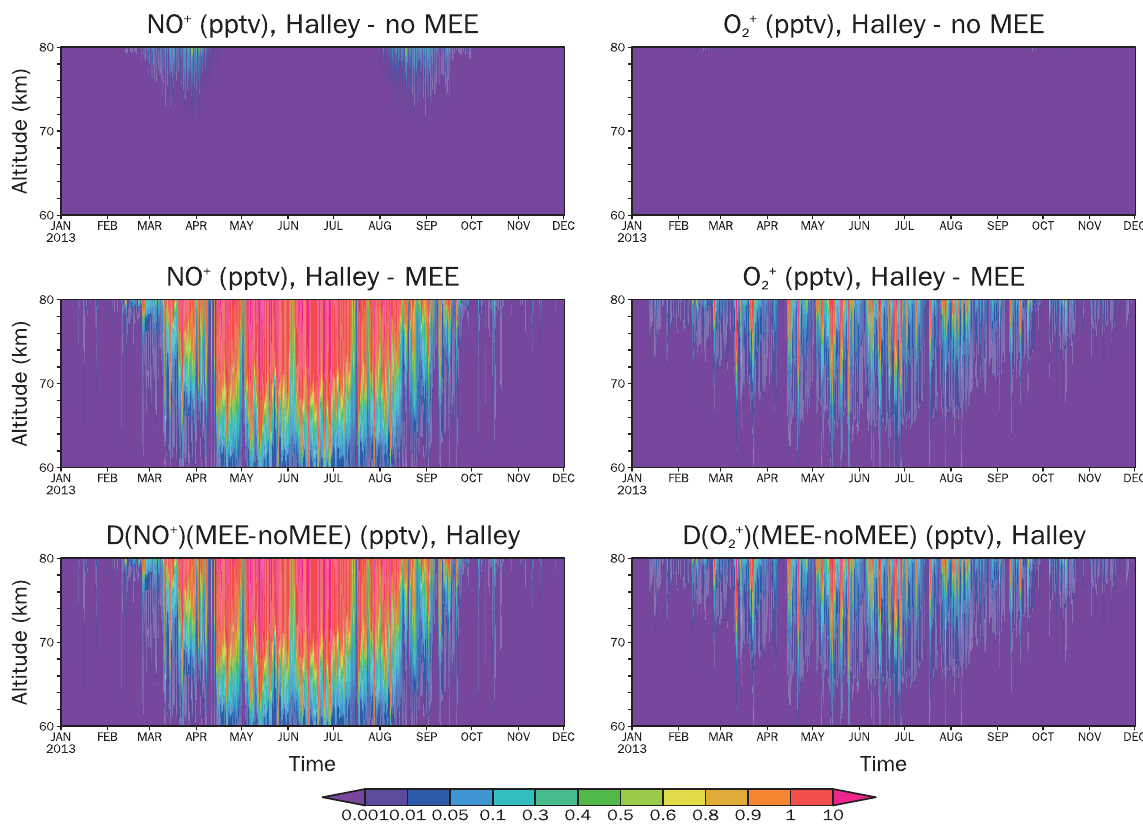
Figure 2. Time series of volume mixing ratio profiles (pptv) of NO + (left panels) and O + WACCM-SIC simulations. Top panels show the values obtained from the model run without medium-energy electrons (MEE); the middle panels show the run with medium-energy electrons; and the bottom panels show the absolute differences between the two model